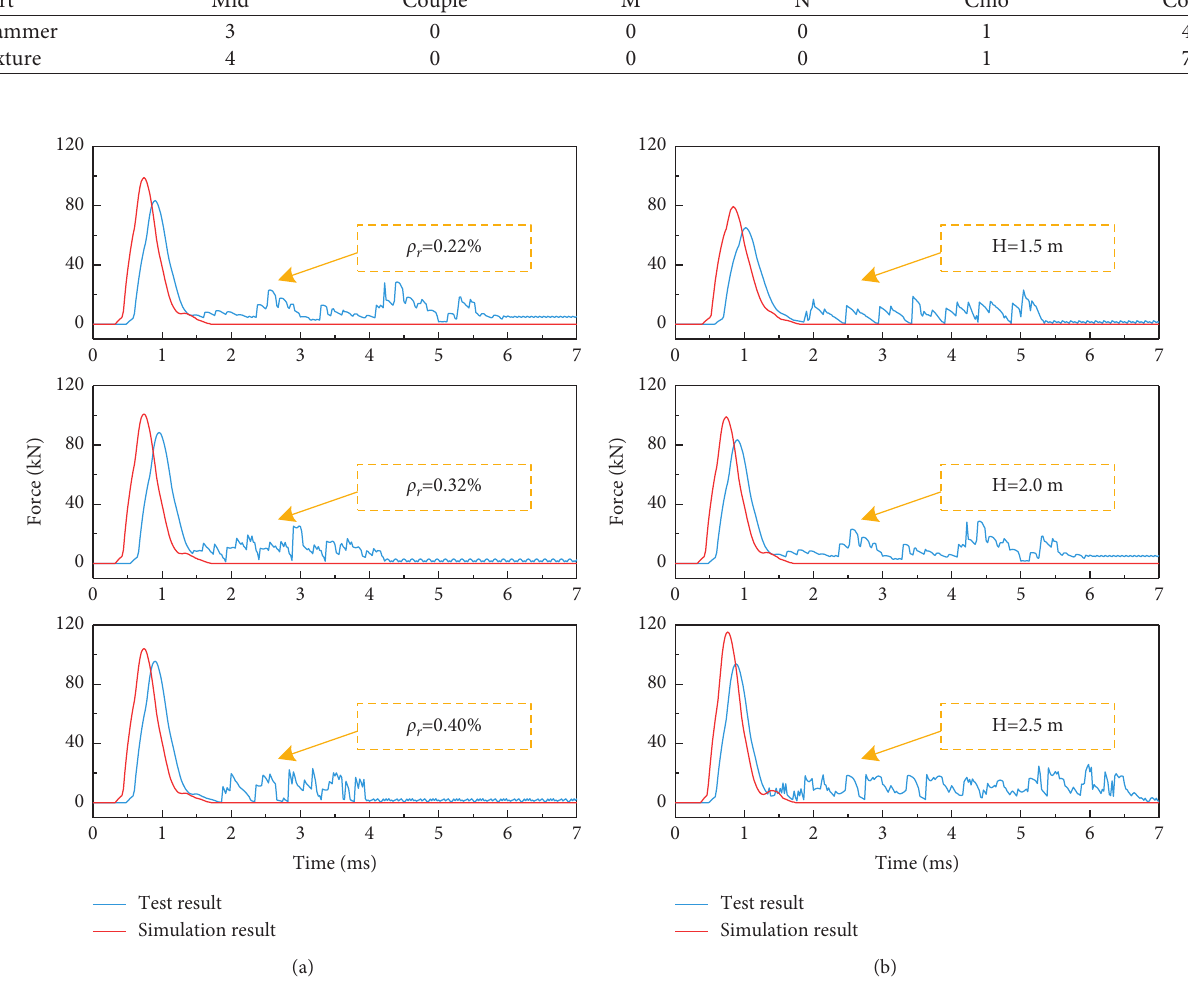
Figure 5: Comparison of impact force time history.